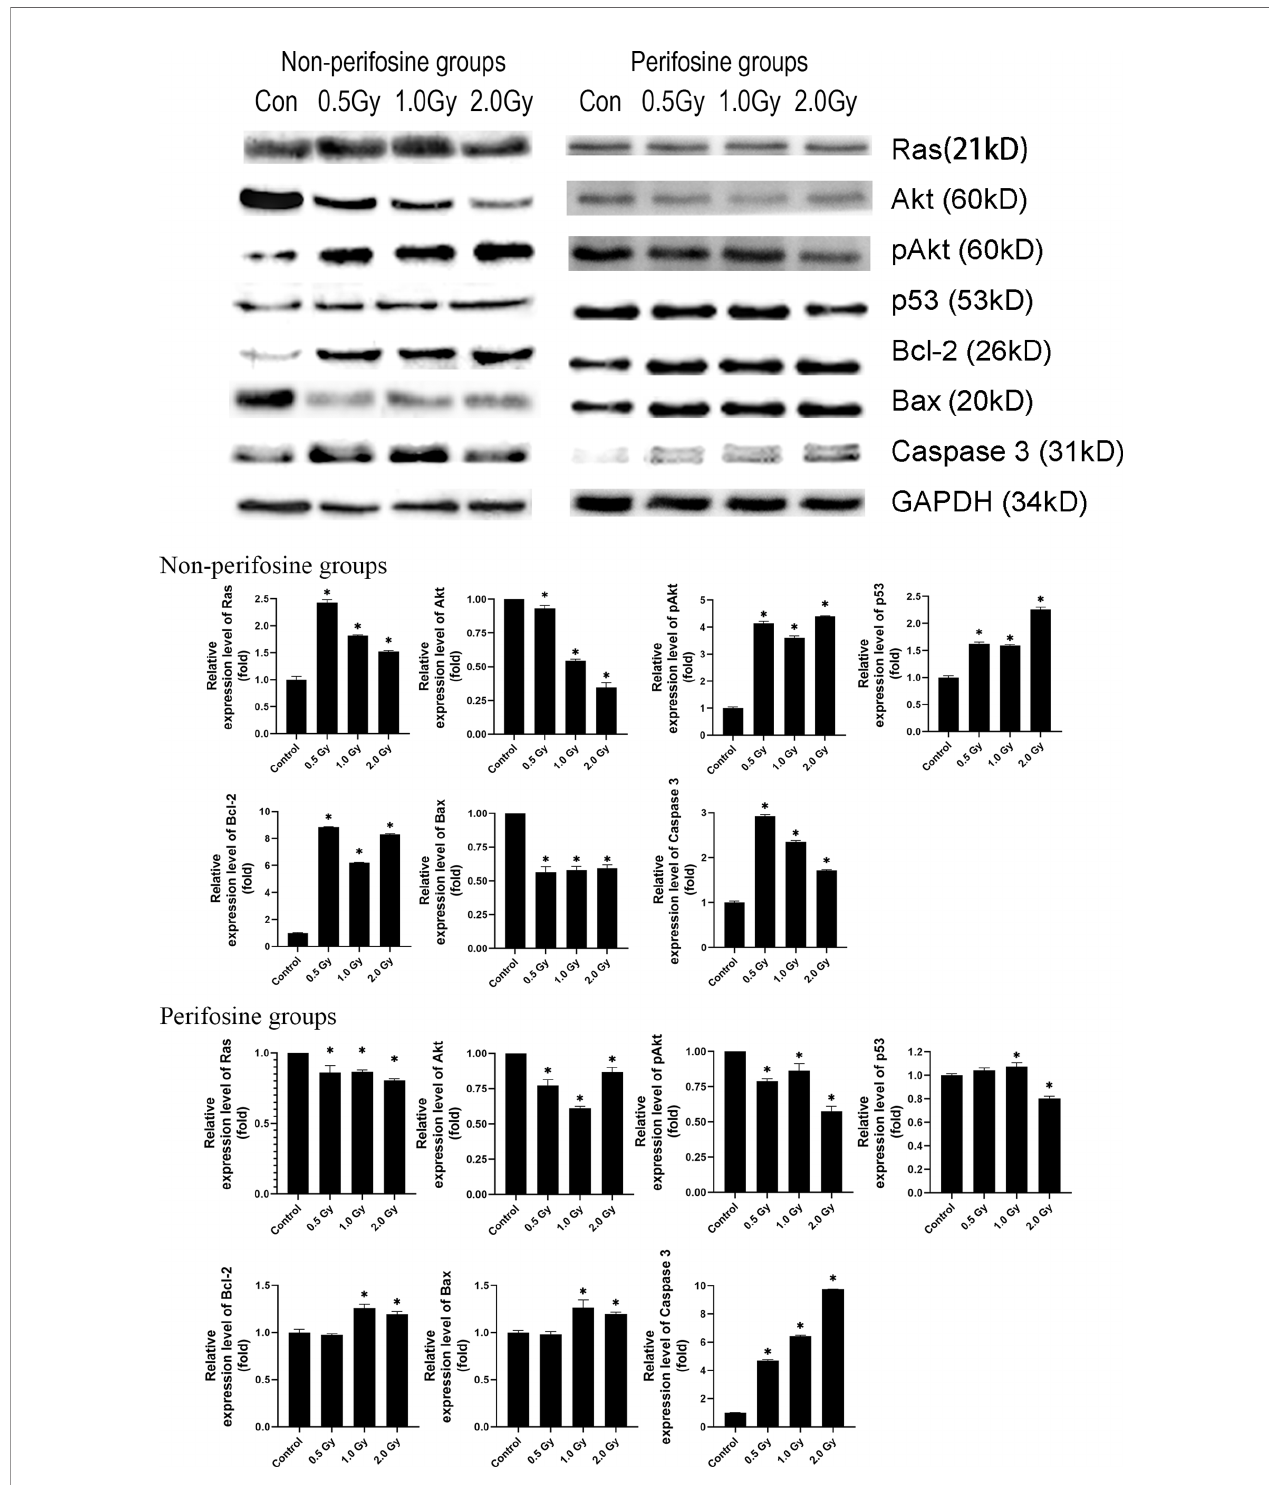
FIGURE 7 | After heavy-ion irradiation with or without perifosine, the expression levels of proteins were determined via western blotting. Glyceraldehyde 3-phosphate dehydrogenase was used as a loading control. Experiments were repeated three times. Representative images of western blots are shown. * p < 0.05 vs. control or other